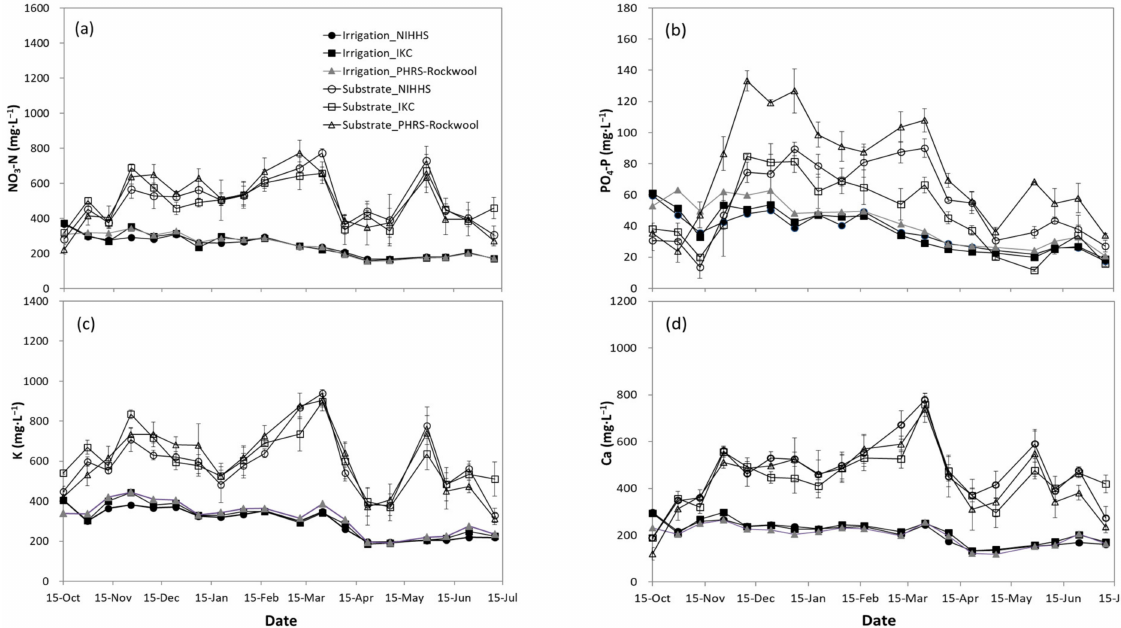
Figure 3. Changes in NO 3 -N ( a ), PO 4 -P ( b ), K ( c ), and Ca ( d ) in the irrigation and RZ according to the compositions of nutrient solutions NIHHS, IKC, and PHRS-Rockwool during the cultivation period. Vertical bars indicate standard errors of the means ( n =